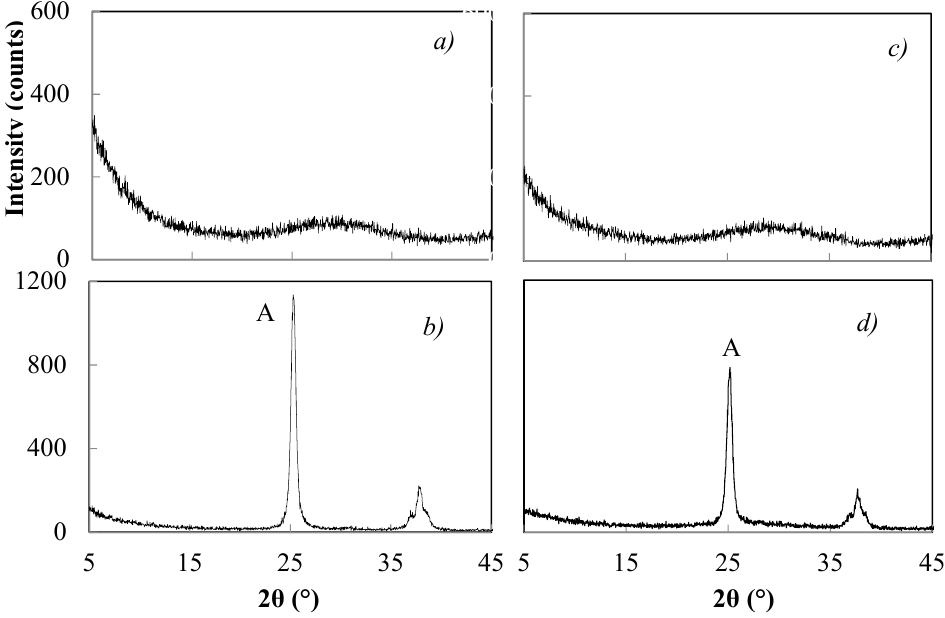
Figure 13. XRD patterns of sample hydrolysed at r.t. for 1 h with 1.0 M NH 4 OH, peptized for 1 h with 0.02 M HNO 3 , dried by lyophilization ( a , b ) or at 60 °C ( c , d ) and calcined for 2 h at 450 °C with a ramp rate of 30 °C/min ( b , d ). (A = anatase).